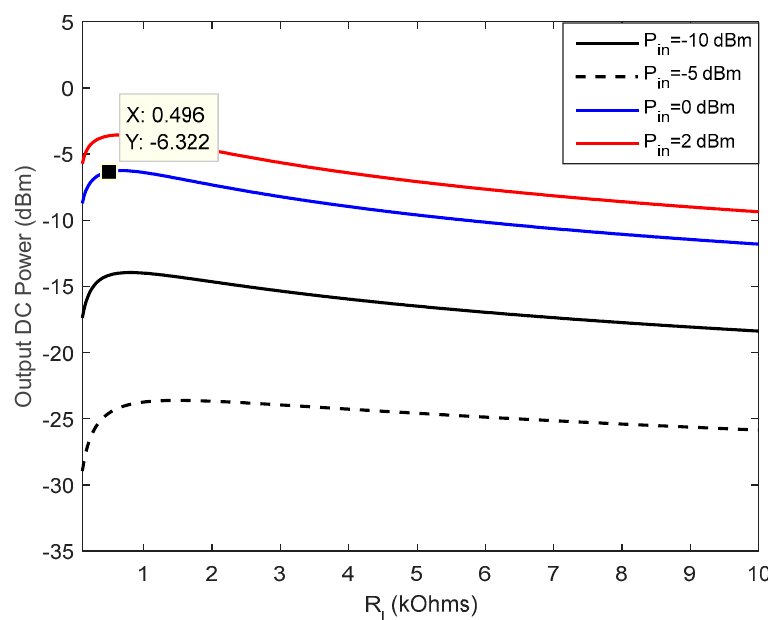
Figure 14. Optimal load resistance of the rectifier.